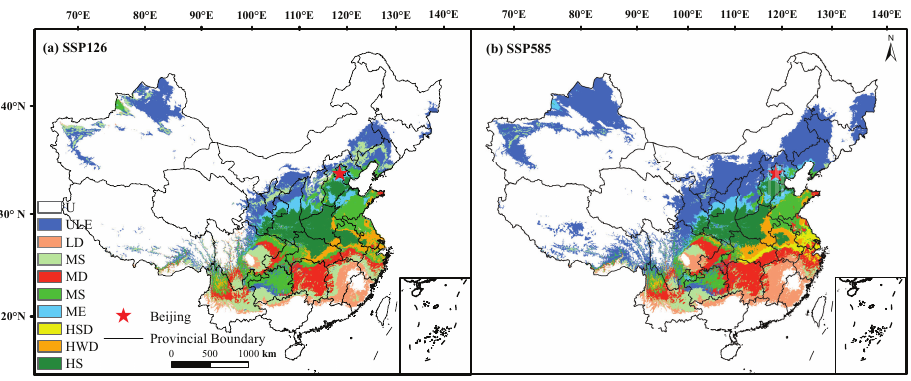
Figure 5. The growth subregions of C. bungei under SSP126 and SSP585. Panel ( a ) indicates the growth subregions under SSP126; panel ( b ) indicates the growth subregions under SSP585. U, ULE, LD, LS, MD, MS, ME, HSD, HWD, and HS represent unsuitable zone, unsuitable and low enhancement zone, low-stable zone, low-degenerate zone, middle-degenerate zone, middle-stable zone, middle- enhancement zone, high-strong degradation zone, high-weak degradation zone, and high-stable zone, respectively. The former of “-” indicates the grade of suitable areas under the current climate, while the latter indicates the average trend of the suitable areas in the next four periods. The degradation zone indicates the grade of current suitable area decline, while the enhancement zone indicates the grade rise. The weak degradation zone indicates the decline of 1 level, while the strong degradation zone grade drops by 2 or more; the stable zone indicates the unchanged